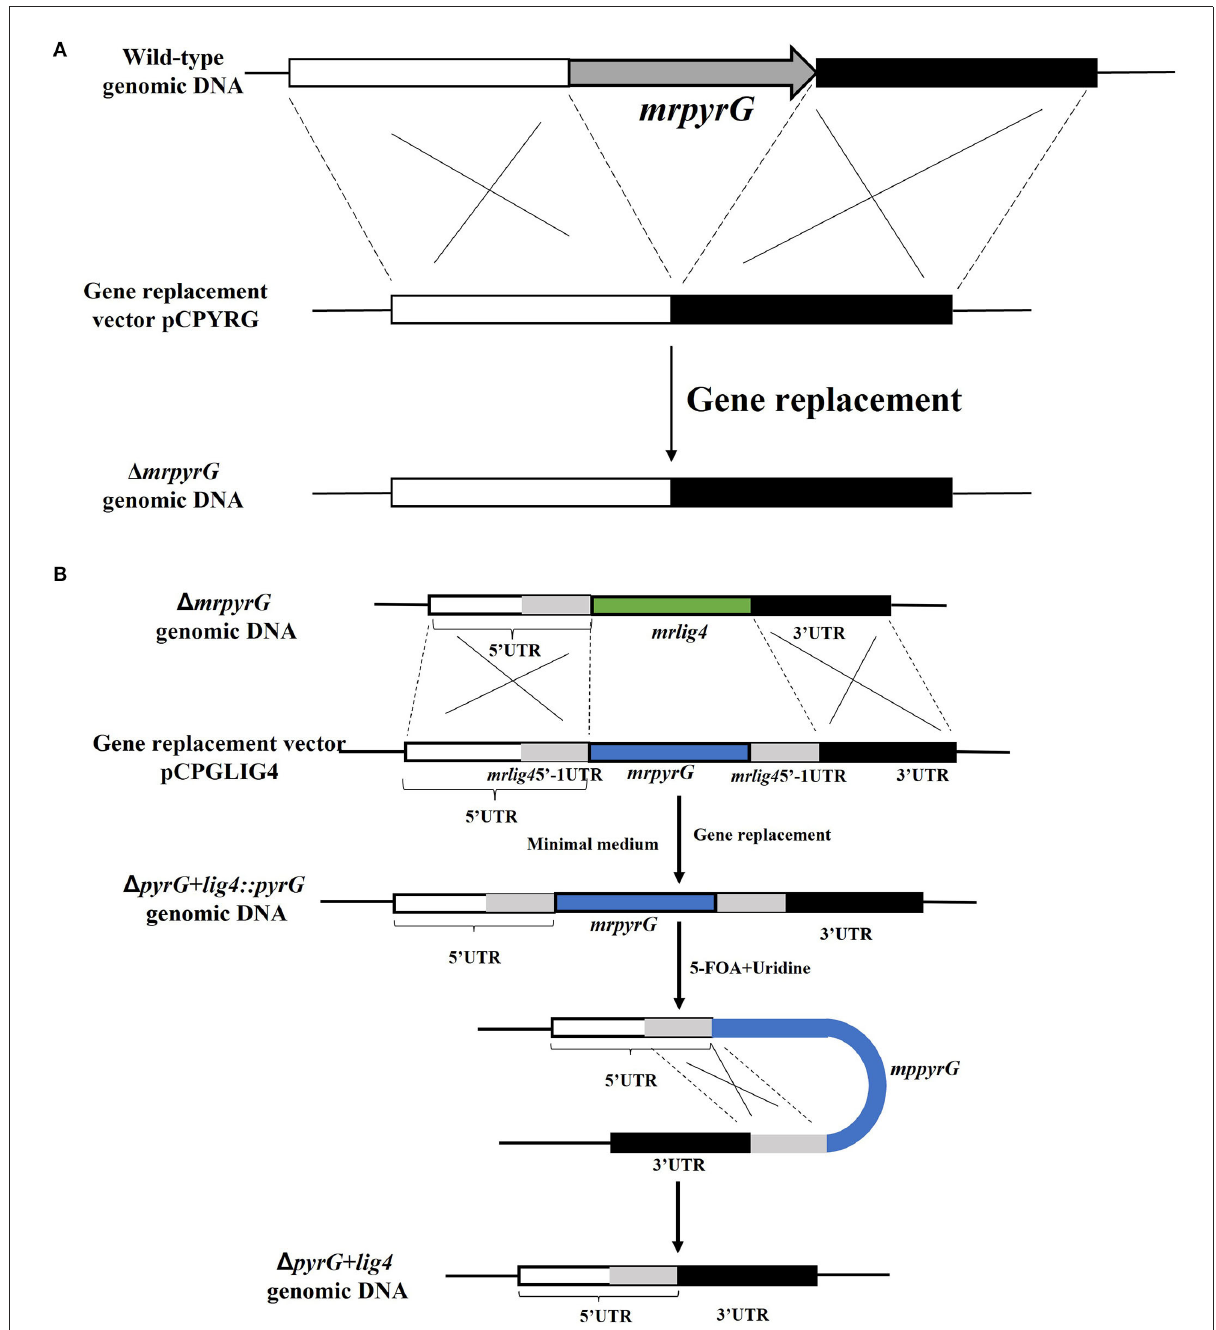
FIGURE1 Deletion of mrpyrG and mrlig4 in M. ruber M7. (A) Strategy to construct mrpyrG markerless deletion strain. (B) Strategy to construct mrlig4 markerless deletion strain.